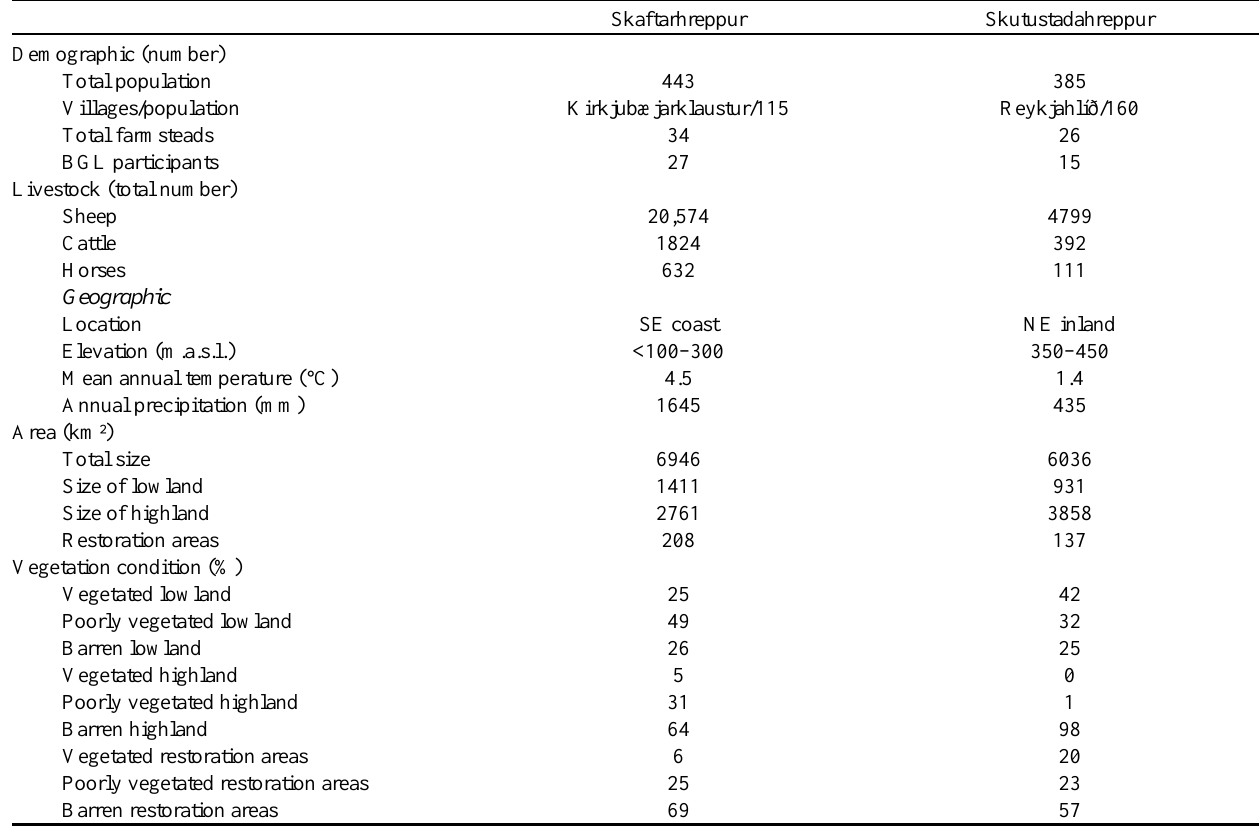
Table 1. Background information for Skaftarhreppur and Skutustadahreppur